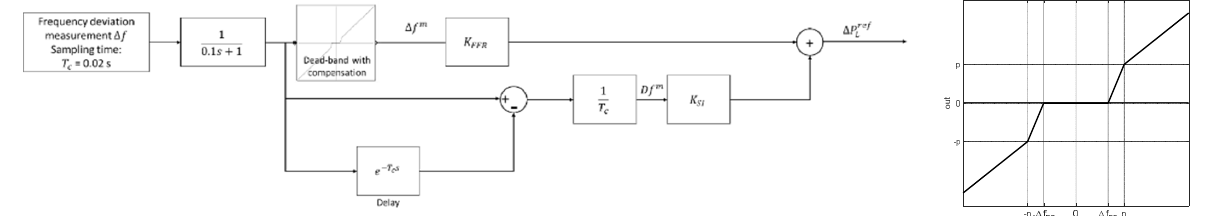
Figure 6. Measurement chain for frequency and RoCoF ( left ). Detail of the dead-band with compensation ( right ).